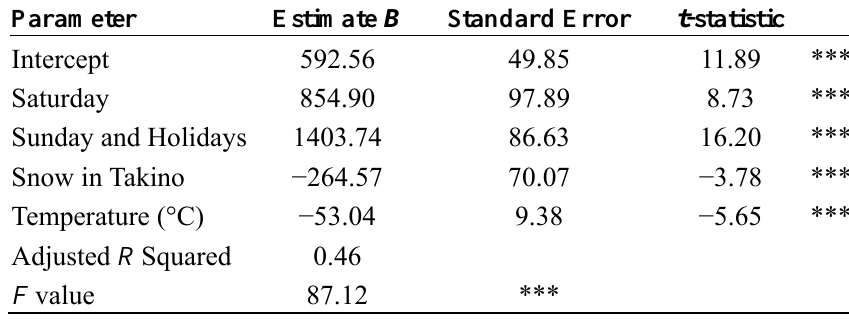
Table 4. Regression analysis for the number of visitors in the snow season in FY 2002–FY 2005, using day of the week and meteorological